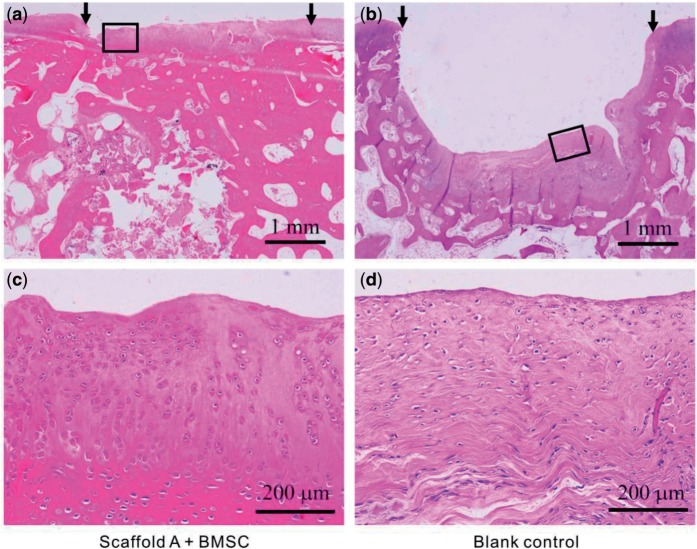
Histological images of reparative tissues 12 weeks after implantation (H&E staining).(a) Tissues repaired by scaffold A with BMSCs; (b) blank control with no implantation; (c) and (d) are the magnified images of the rectangles in (a) and (b), respectively. The arrows indicate the initial defect site.